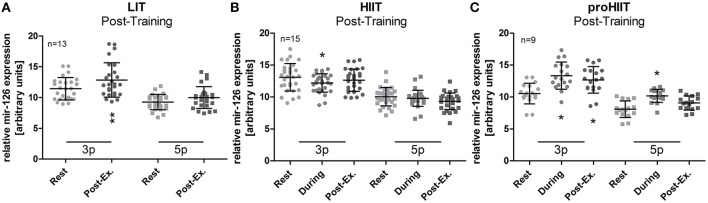
miR-126 levels were increased in response to exercise in the LIT and proHIIT group post-training. After the 4-week training intervention, a significant increase of acute miR-126 levels was detected post-exercise (A) in the LIT group and (C) in the proHIIT group (run 7), while miR-126-3p levels were still reduced in (B) the HIIT group (run 4). Elevated miR-126-5p levels were only detected during exercise (run 4) in the proHIIT group. miRNA levels at follow-up were analyzed directly after the last run (run 4) and after 3 min of recovery (post-exercise) in the HIIT group. In the proHIIT group, miRNA levels were analyzed during the exercise (run 4) and directly after the exercise (run 7, post-exercise). Data are represented as mean ± SD. P-values are rest vs. post-exercise using ANOVA. *p < 0.05; **p < 0.01.